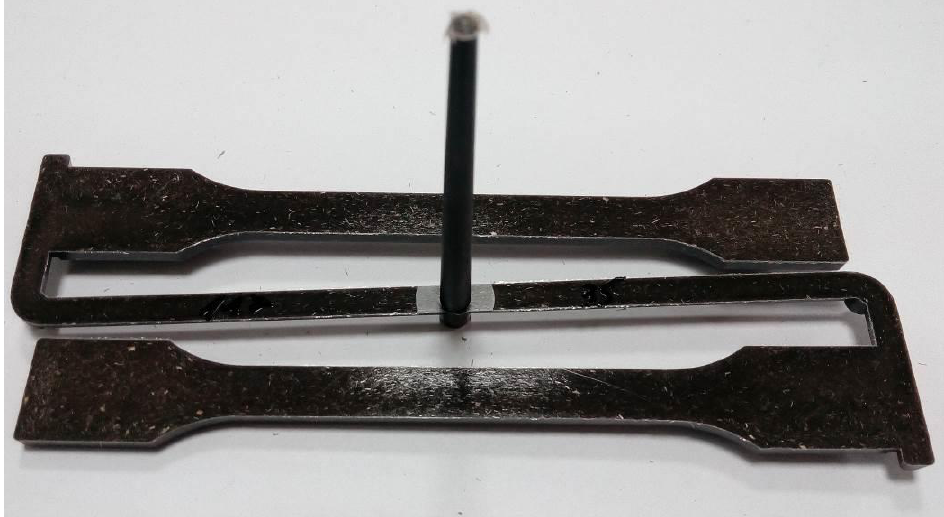
Figure 2. Samples made of PHBV – flax fiber biocomposite (30 wt.%).